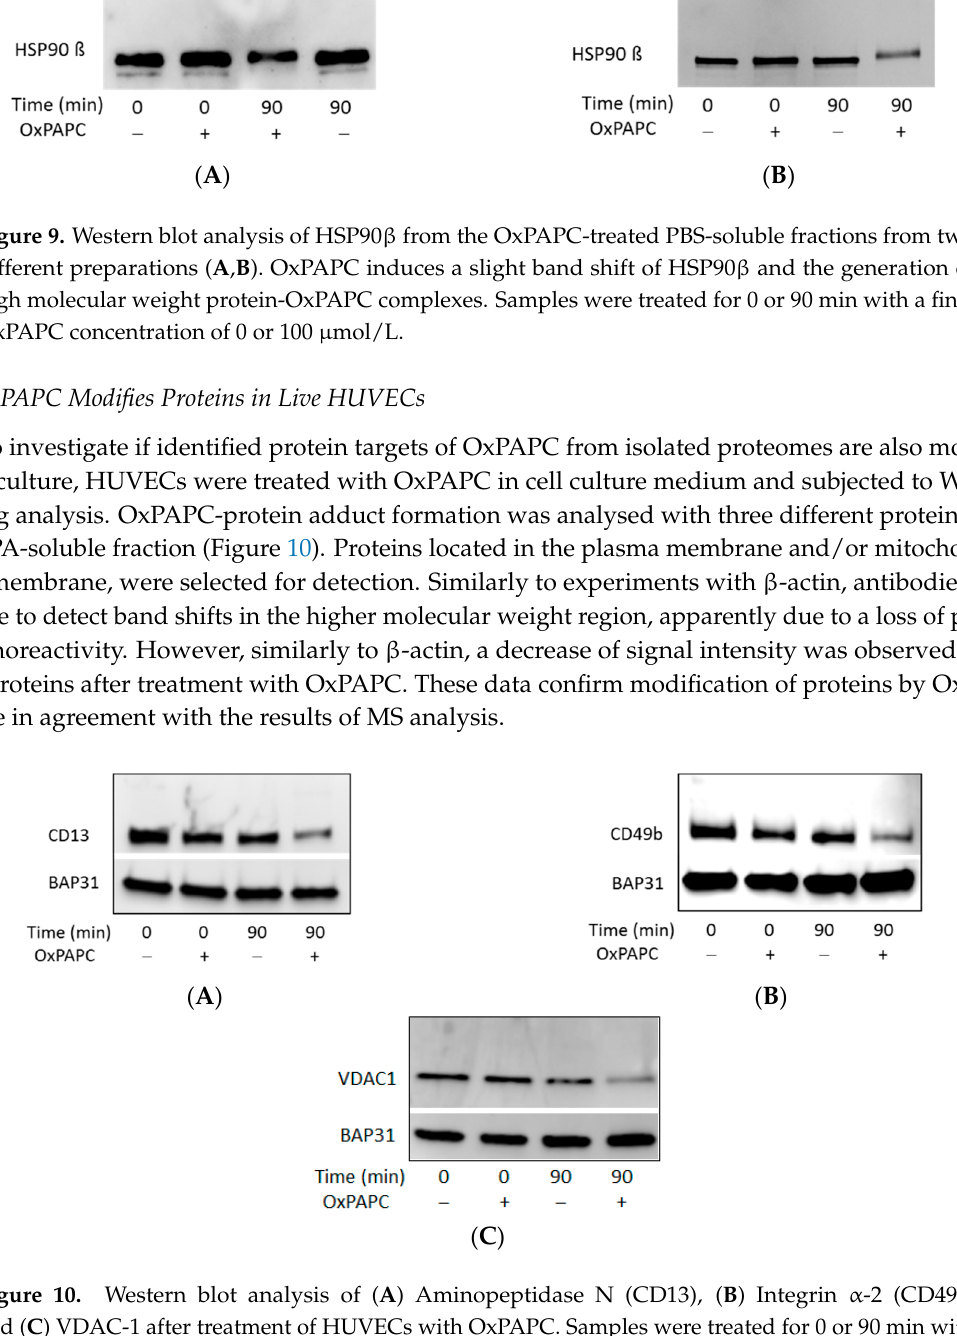
Figure 8. Western blot analysis of β -Actin from the formaldehyde-treated samples. After any more.